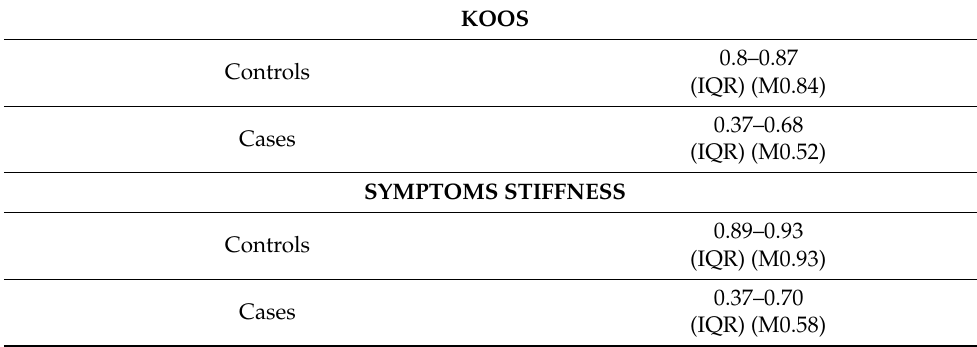
Table 5. Descriptive analysis of all clinical data. Median and Interquartile Range values of all clinical data analyzed (KOOS, function daily living, function sports and recreational activity, quality of life) in healthy controls and pathological